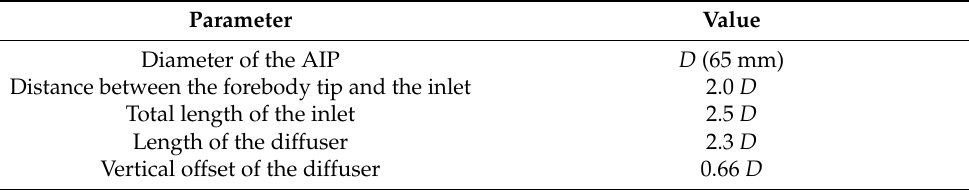
Figure 1. ( a ) Geometry and ( b ) experimental setup of the serpentine inlet of NUAA Inlet Research Group [33]. Table 1. Main geometric parameters of the ultra-compact serpentine inlet.